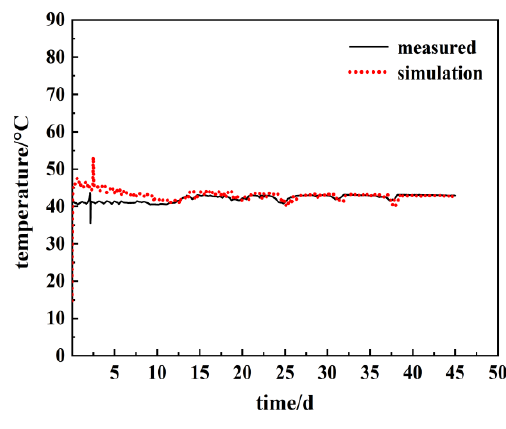
Figure 4. Produced flow temperature fitting curve.